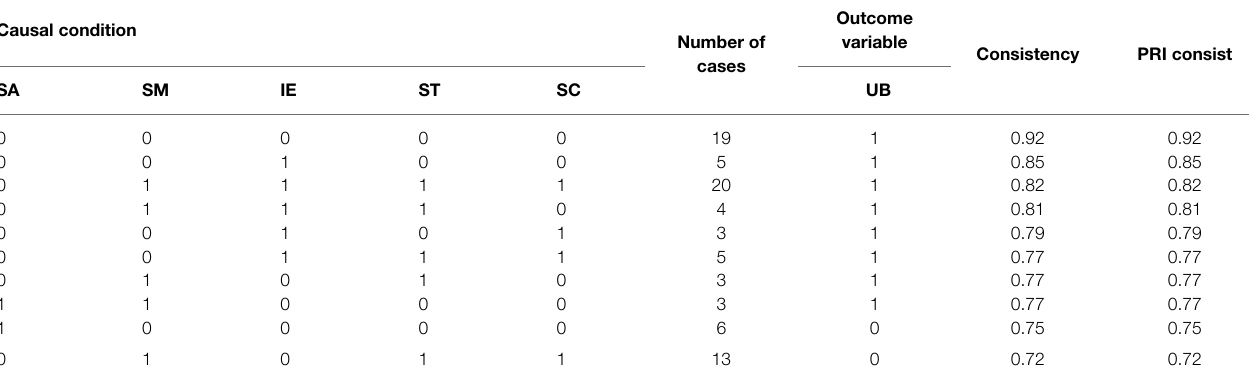
TABLE 9 | True table